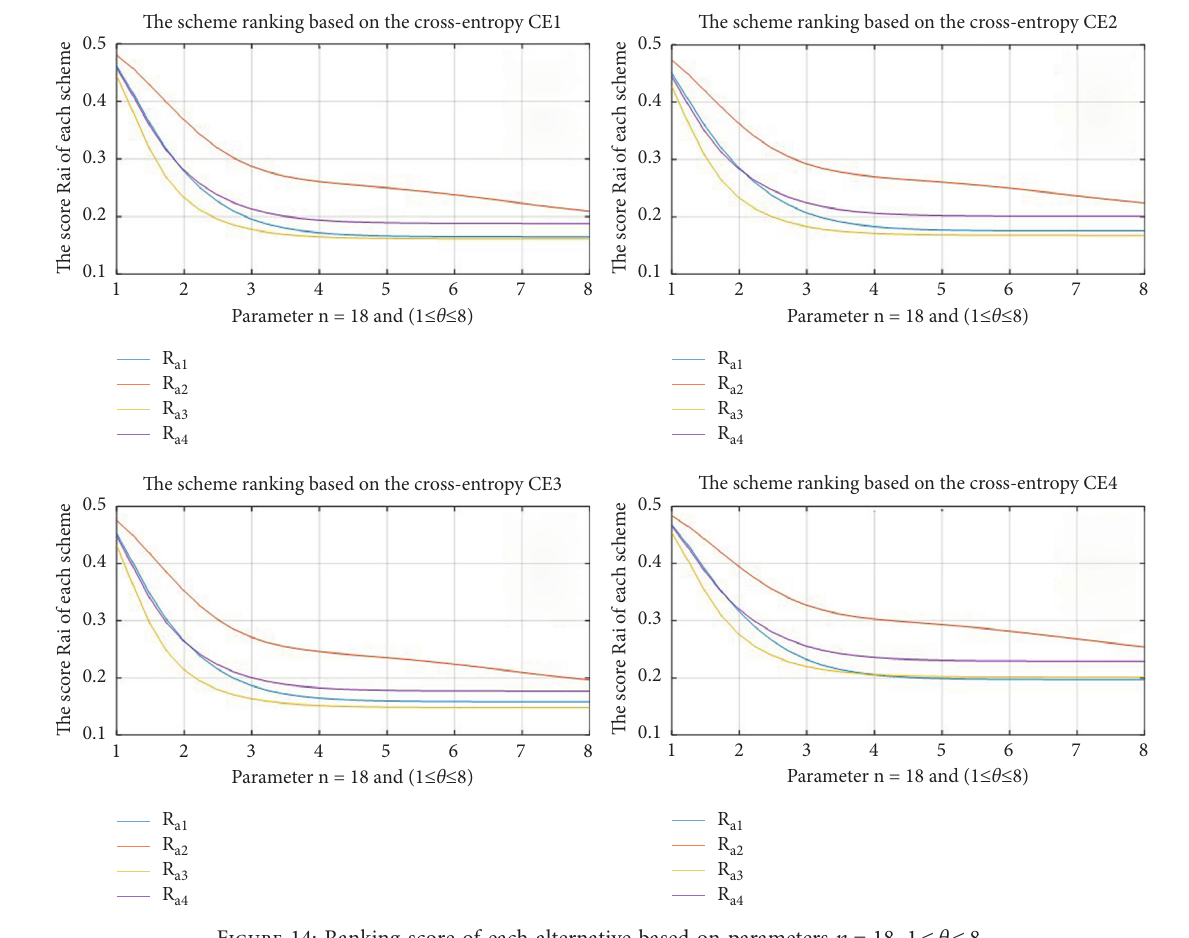
Figure 14: Ranking score of each alternative based on parameters n � 18, 1 ≤ θ ≤ 8.